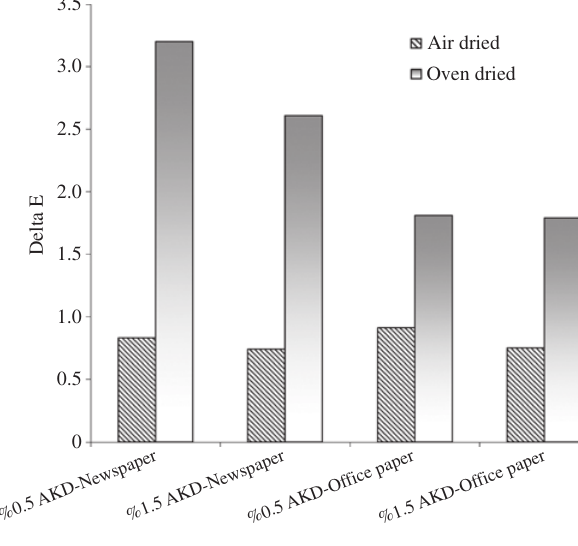
Figure 3: Drying reduced surface free energy (mJ/m 2 ) of papers.